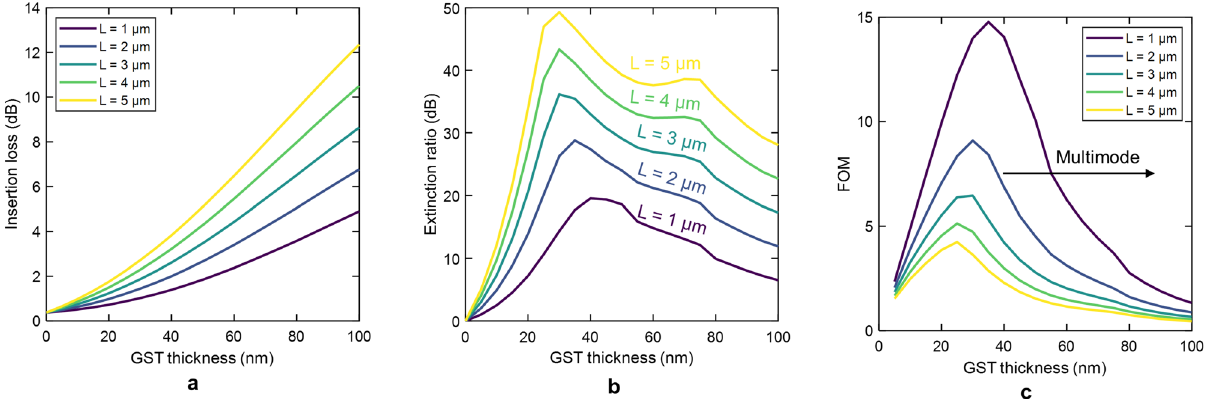
Figure 6. Optical performance of GST-loaded silicon waveguides calculated by eigenmode expansion as a function of the GST thickness and for different lengths. ( a ) Insertion loss. ( b ) Extinction ratio. ( c ) Figure of